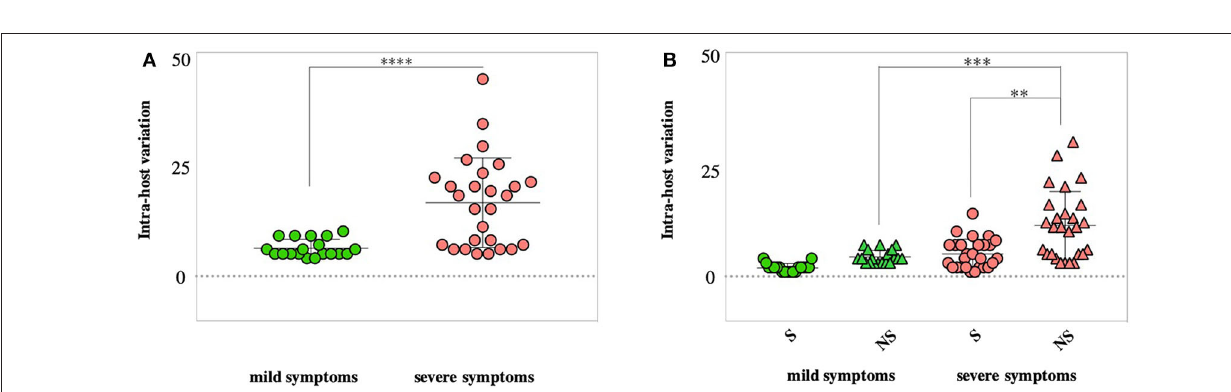
FIGURE 6 | Assessment of within-host SARS-CoV-2 diversity. (A) Total number of variants detected in each patient with mild (green) and severe (red) symptoms. (B) Number of synonymous (S) and non-synonymous (NS) mutations found within each patient of the two groups (mild vs. severe cases). P -values are indicated as follows: **** p < 0.0001, *** p <